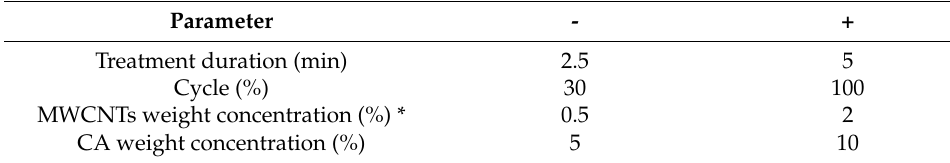
Table 2. Parameters of ultrasonic sonotrode (USS).